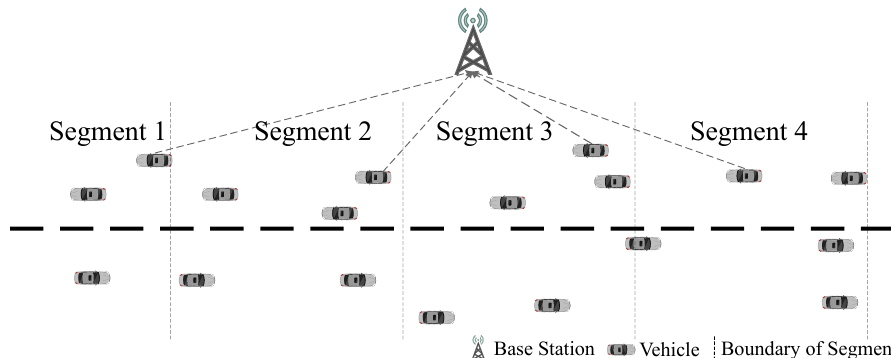
Figure 4. CSI Based Road Segments.